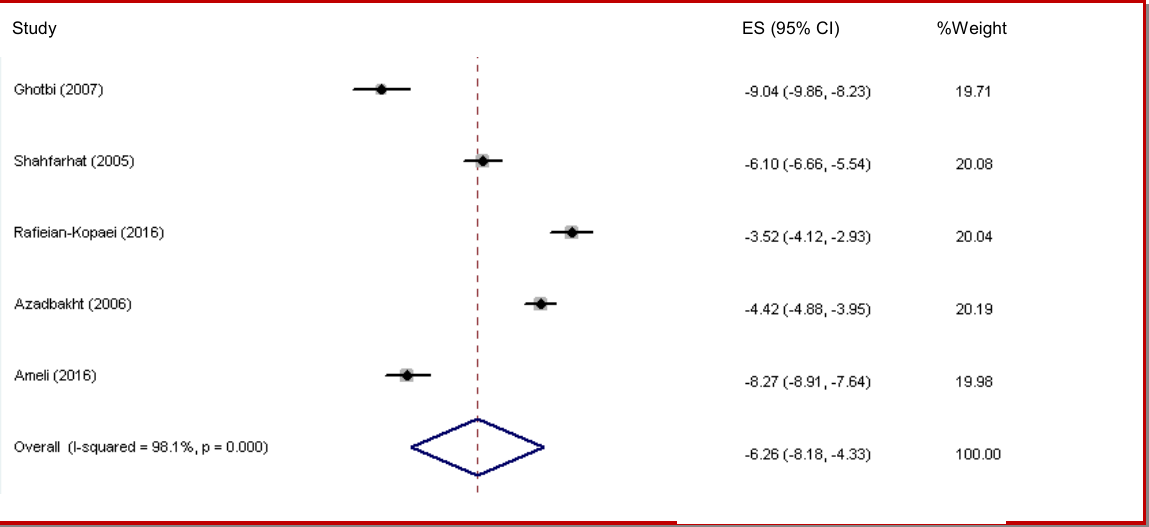
Figure 3: The summary or combined Weighted Mean Differ- ence (WMD) of bilirubin in intervention versus comparison groups across different assessed times 0-72 hours